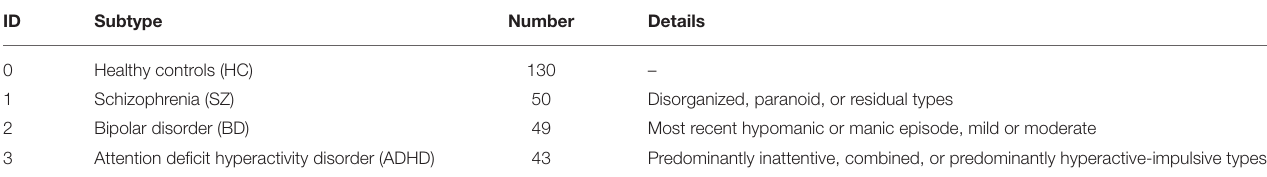
TABLE 1 | Details of the Consortium for Neuropsychiatric Phenomics (CNP)